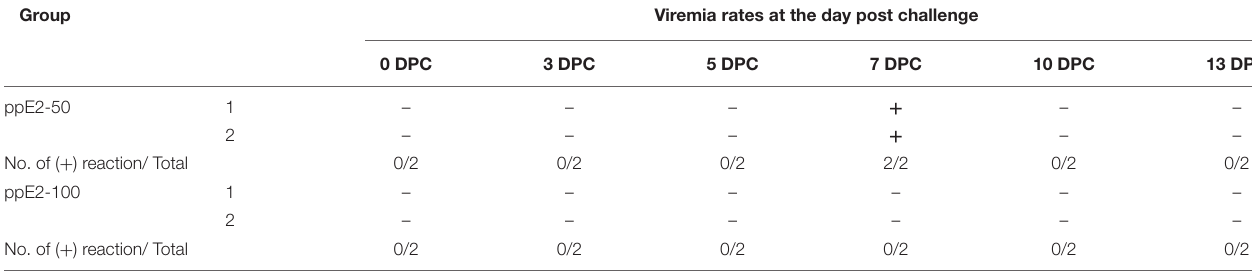
TABLE 1 | Detection of viremia in serum from vaccinated piglets challenged with classical swine fever virus. Group Viremia rates at the day post challenge